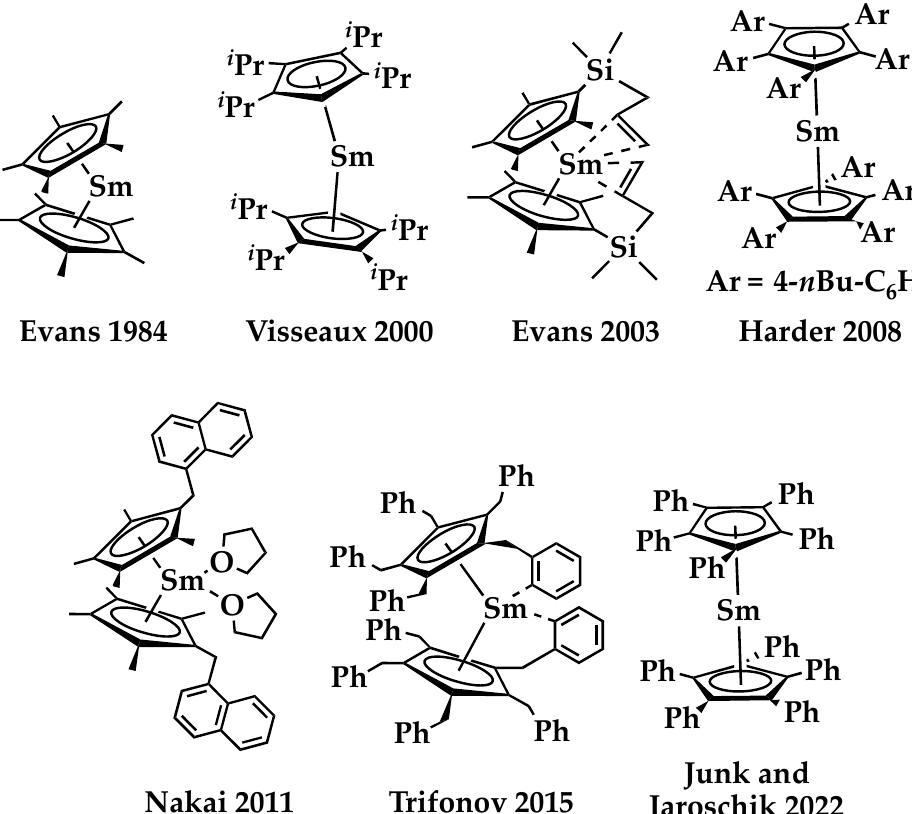
Scheme 1. Examples of crystallographically characterized Sm(II) metallocene complexes.